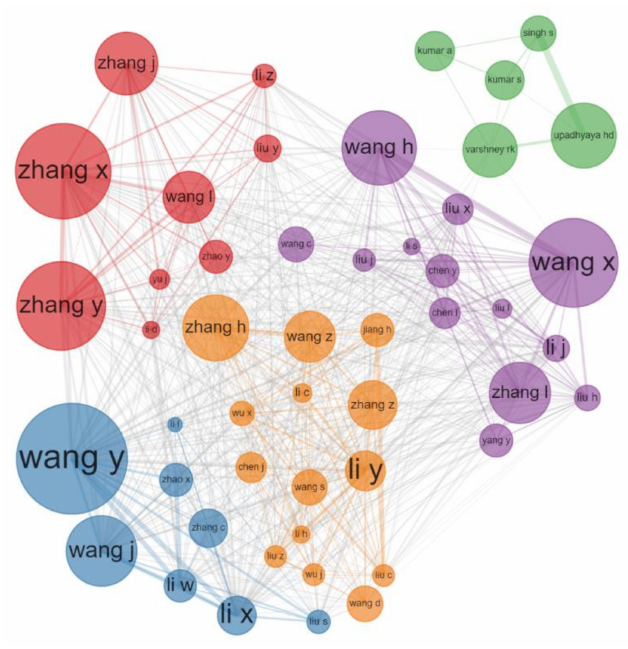
Figure 2. Author collaboration